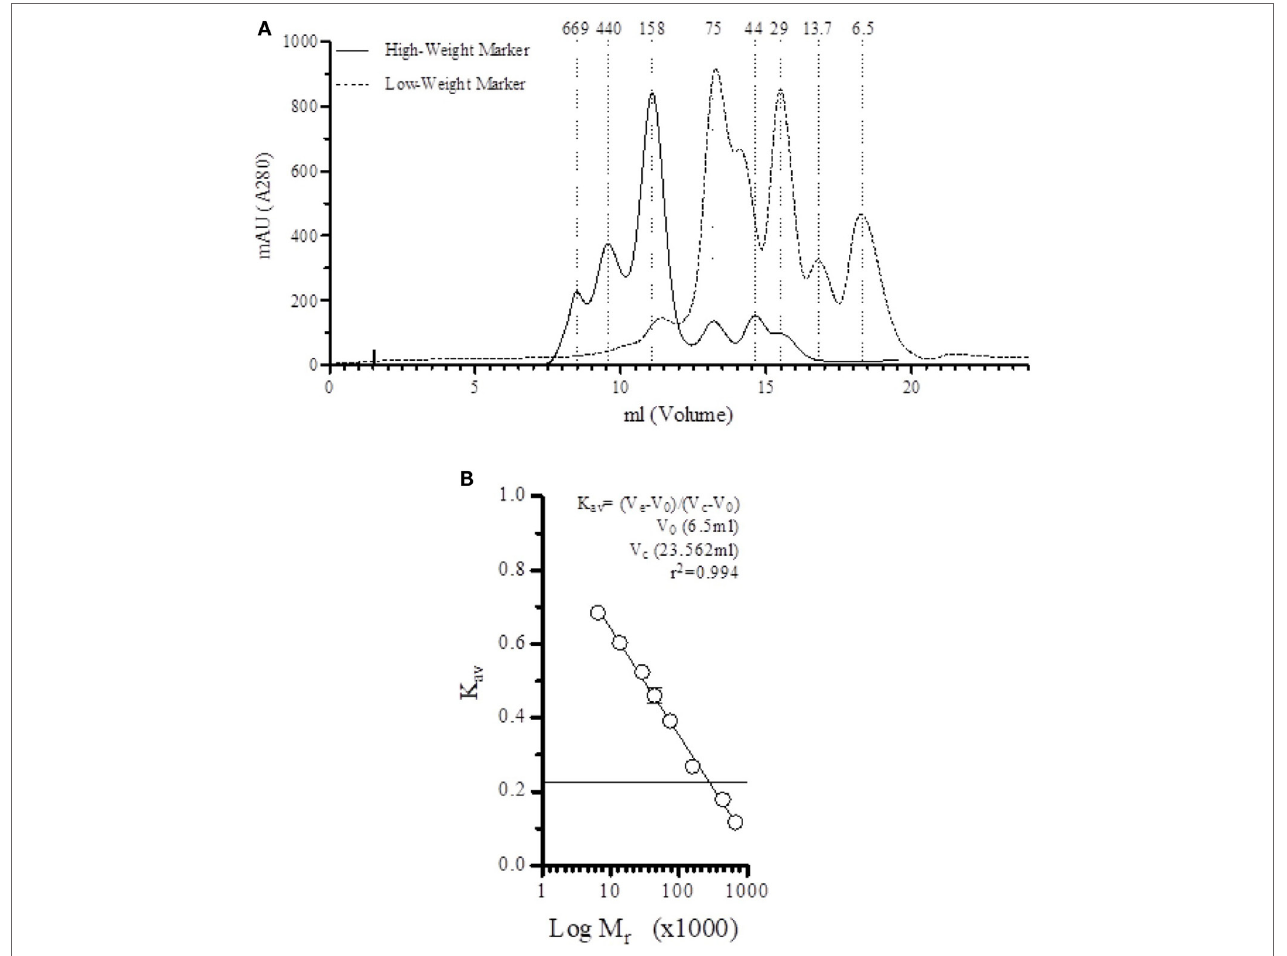
FigUre 1 | Direct correlation between elution fraction and size. (a) Elution profile of low-weight and height-weight markers on the Superdex ™ 200 10/300 GL in veronal-buffered saline (1 M NaCl, pH 7.4). (B) A strong correlation ( r 2 = 0.994) is found between the elution volume and the marker